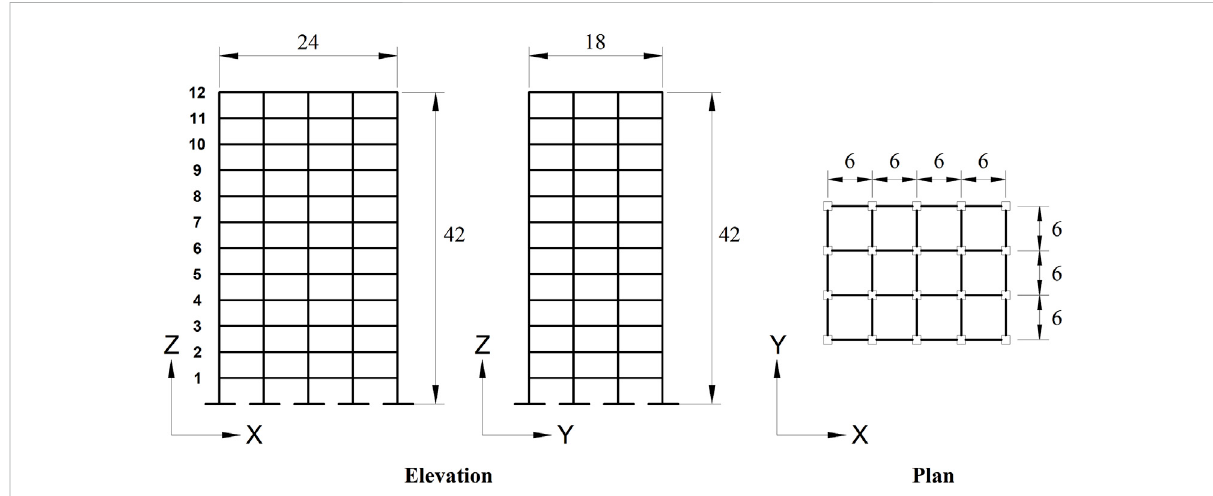
FIGURE 4 General dimensions of the analyzed buildings (units in meters).